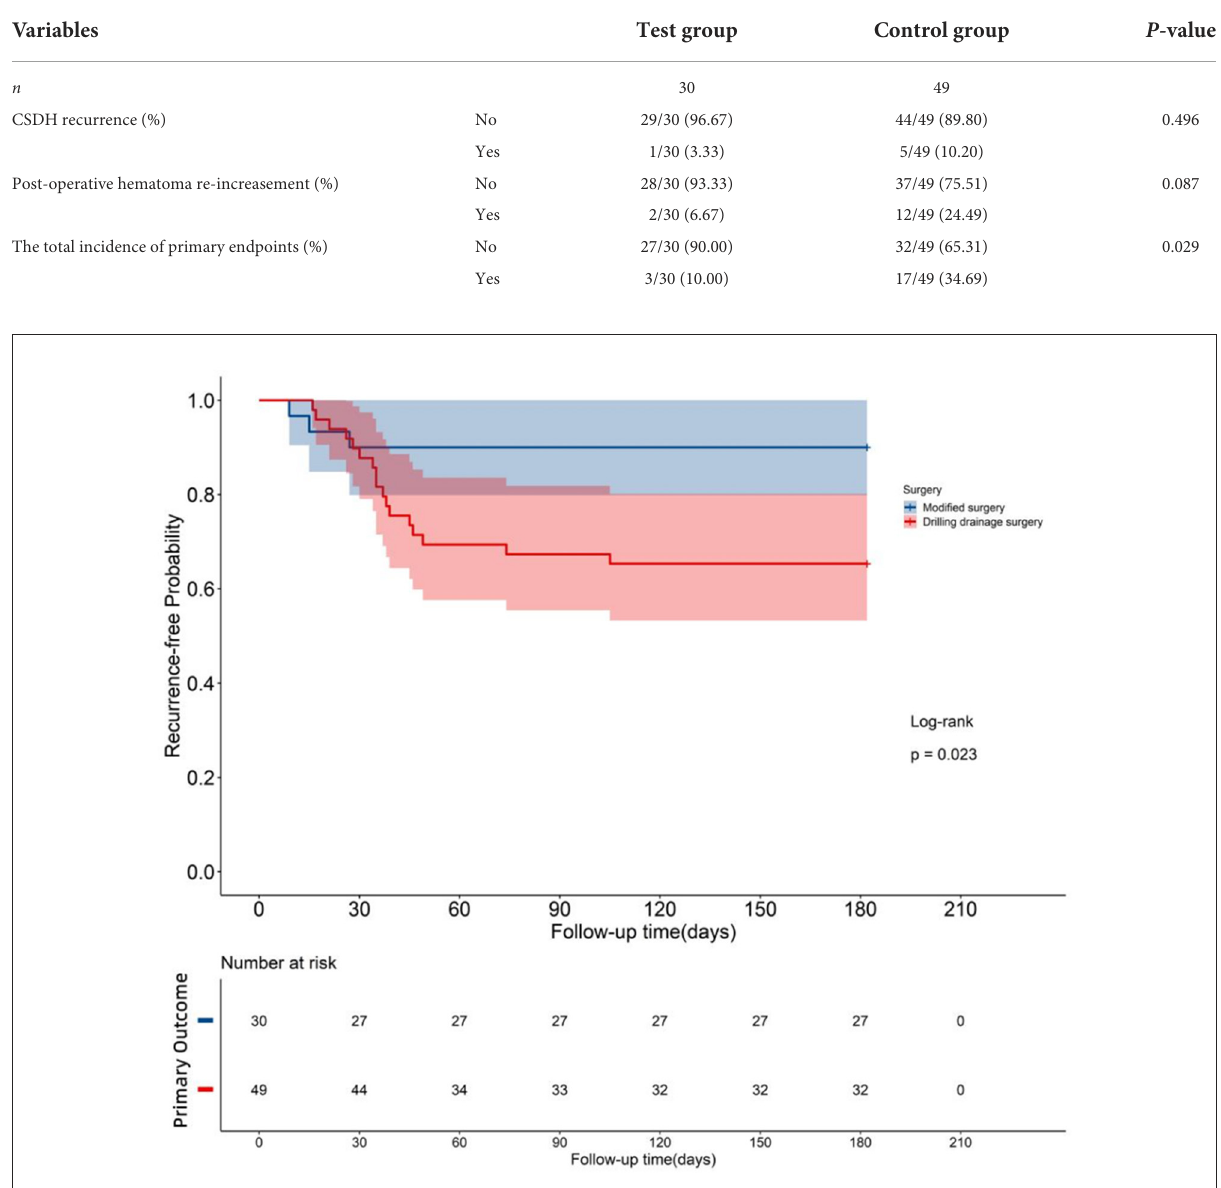
FIGURE5 Survival curve: Both groups were monitored for 6 months after the operation, and the survival curves of the two groups were drawn. P = 0.023 < 0.05, indicating significant differences in the post-operative survival condition between the two groups. The survival rate of the test group that underwent modified surgery was greater than that of the control group that underwent traditional